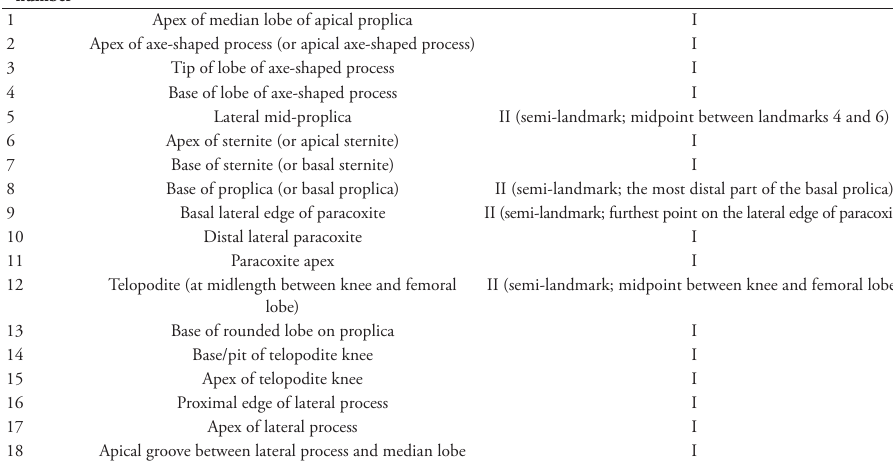
Table 2. Description of B . flavicollis gonopod landmarks and semi-landmarks used for shape analysis.